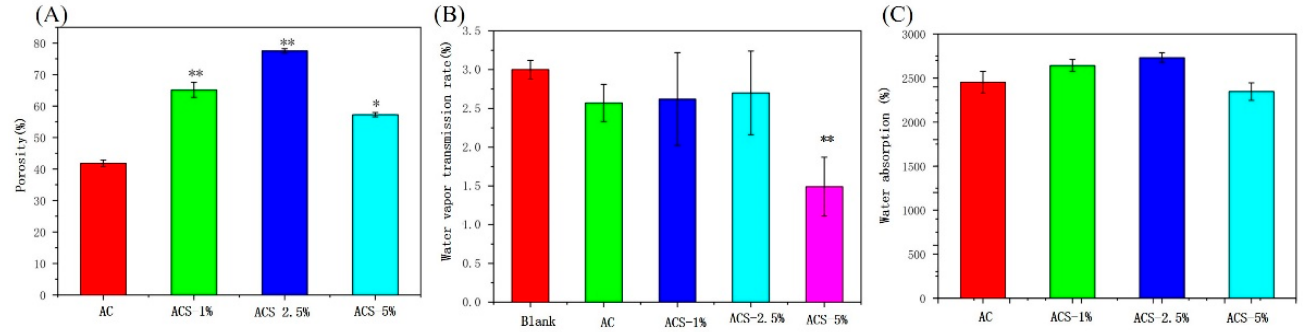
Figure 3. ( A ) Porosity of AC, ACS—1%, ACS—2.5%, and ACS—5% sponges. Data are the mean ± SD for each group (n = 3), * Significant difference from the AC group, * p < 0.05, ** p < 0.01. ( B ) Water vapor transmission rate of blank, AC, ACS—1%, ACS—2.5%, and ACS—5% sponges. Data are the mean ± SD for each group (n = 3), * Significant difference from the blank, ** p < 0.01. ( C ) Water absorption capacity of AC, ACS—1%, ACS—2.5%, and ACS—5% sponges.